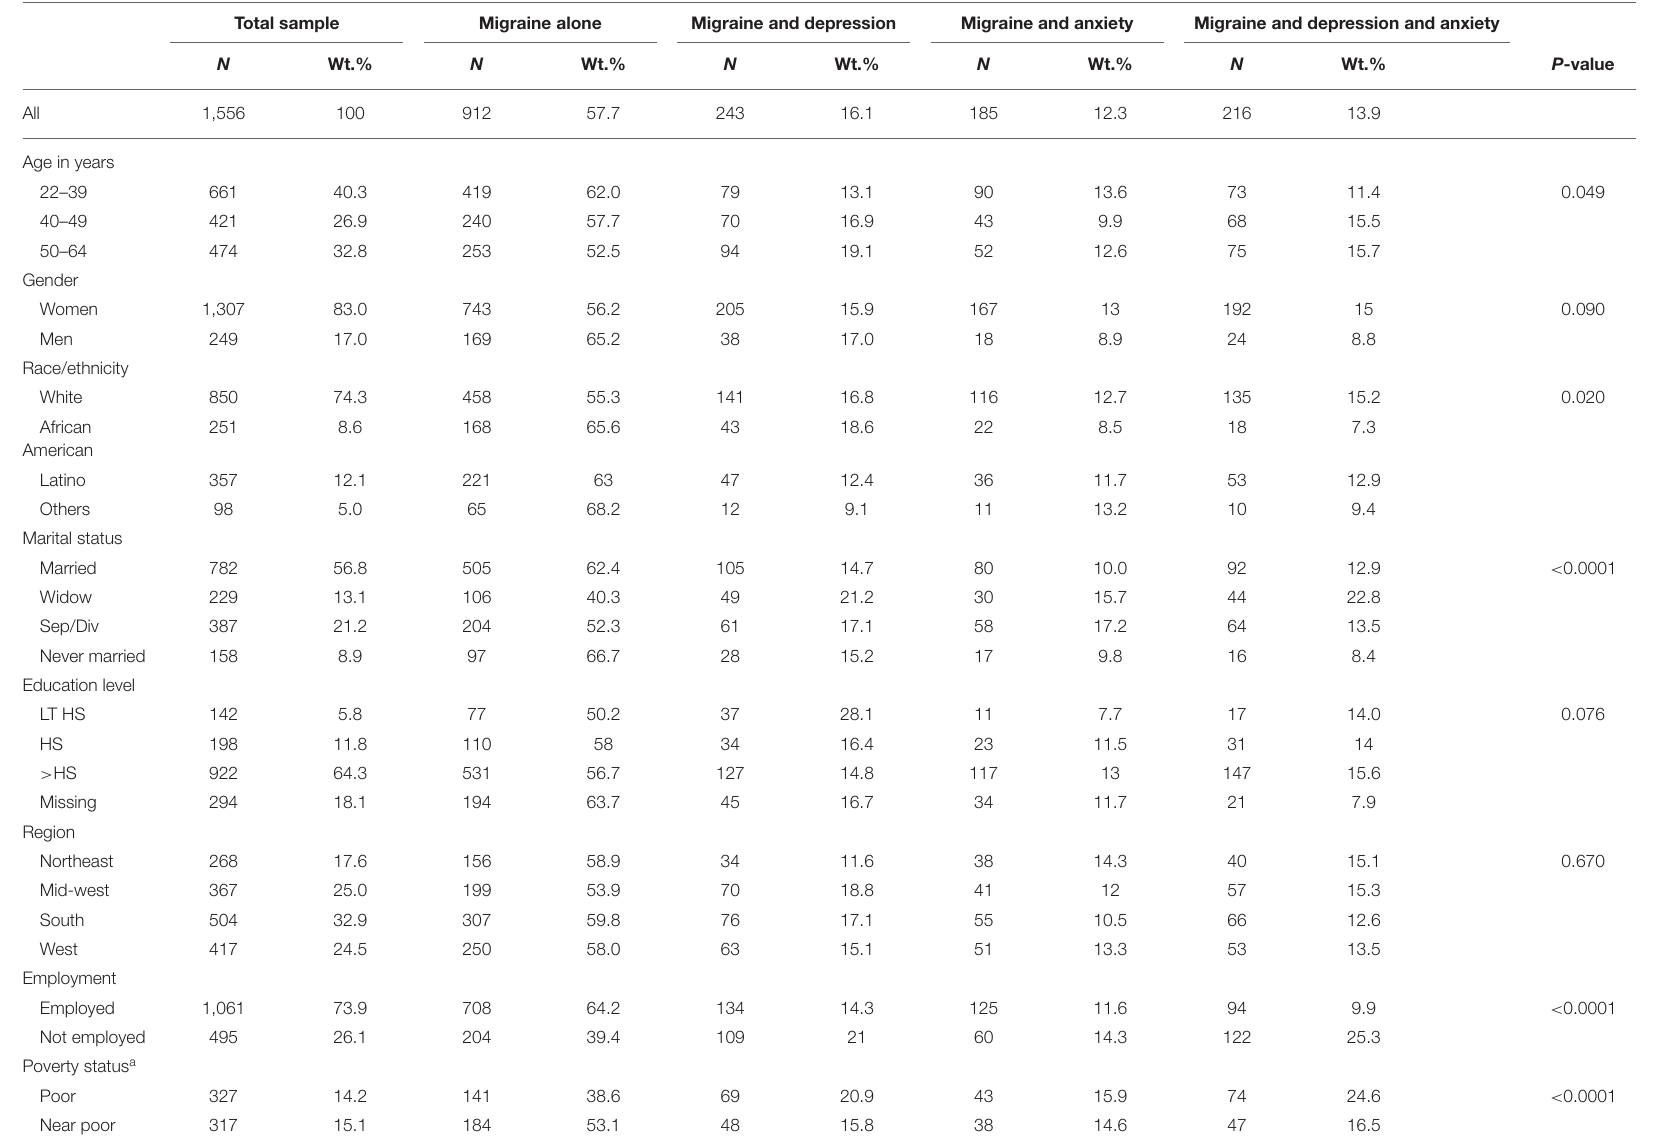
TABLE 1 | Characteristics of the study sample and number and row percentage of characteristics by migraine group among adults with migraine (Medical Expenditure Panel Survey data of 2012, 2014, and 2016). Total sample Migraine alone Migraine and depression Migraine and anxiety Migraine and depression and anxiety Wt.%